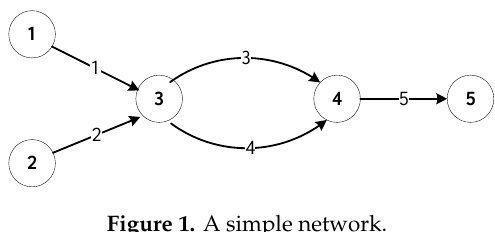
Figure 1. A simple network. Table 1. Link parameters of network in Figure 1.